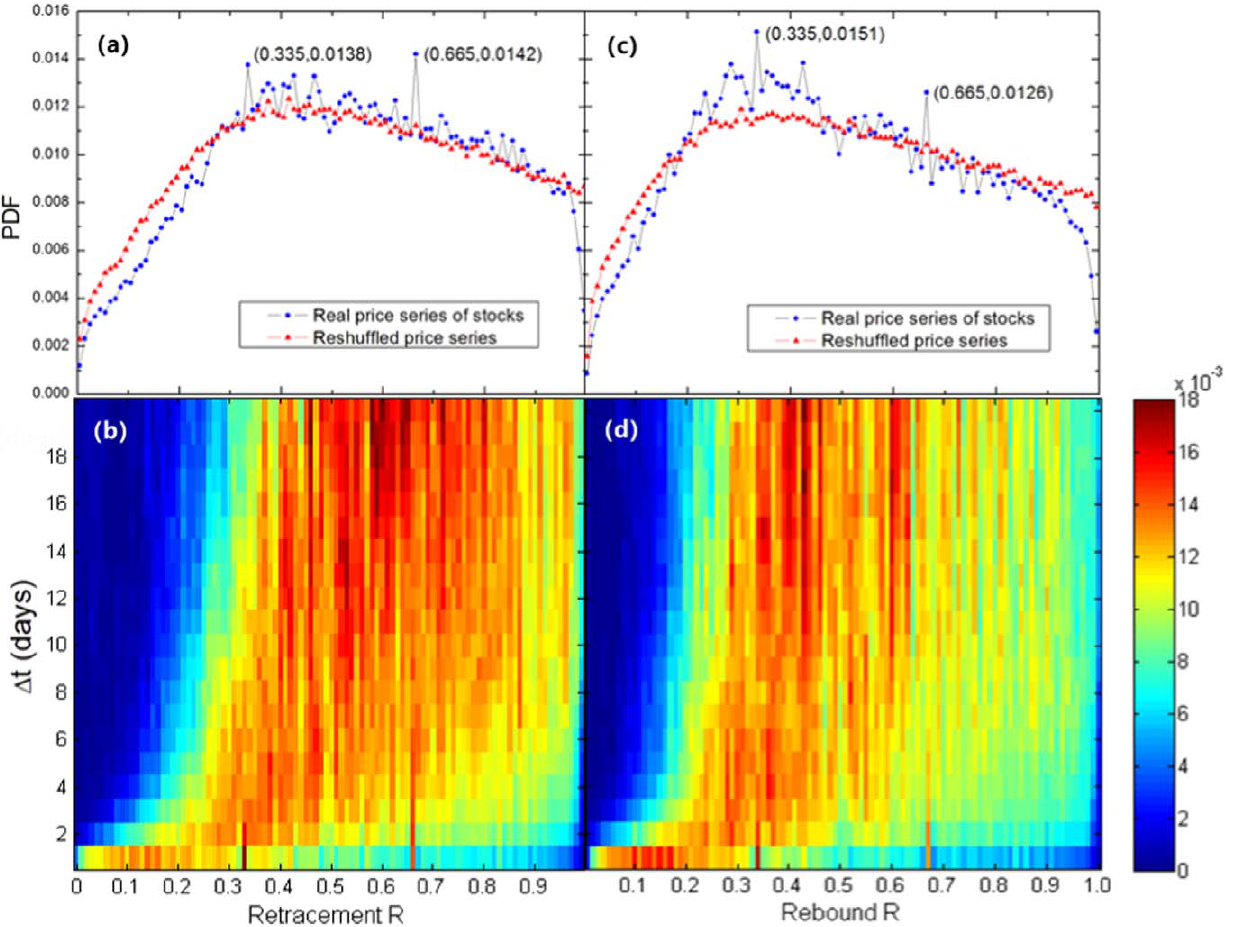
Figure 3. (Color online) The same as Fig.2, but for the Chinese stock market. (a,c) Overall PDF calculated over D t from 1 day to 20 days and over all trend reversals in the price series of all 300 stocks of the Shanghai Shenzhen CSI 300 index. Peaks can also be found at R t (or R b )=0.335 and R t (or R b )=0.665. (b,d) The colored PDF profiles. Ridges can also be found at R t (or R b )=0.335 and R t (or R b )=0.665.